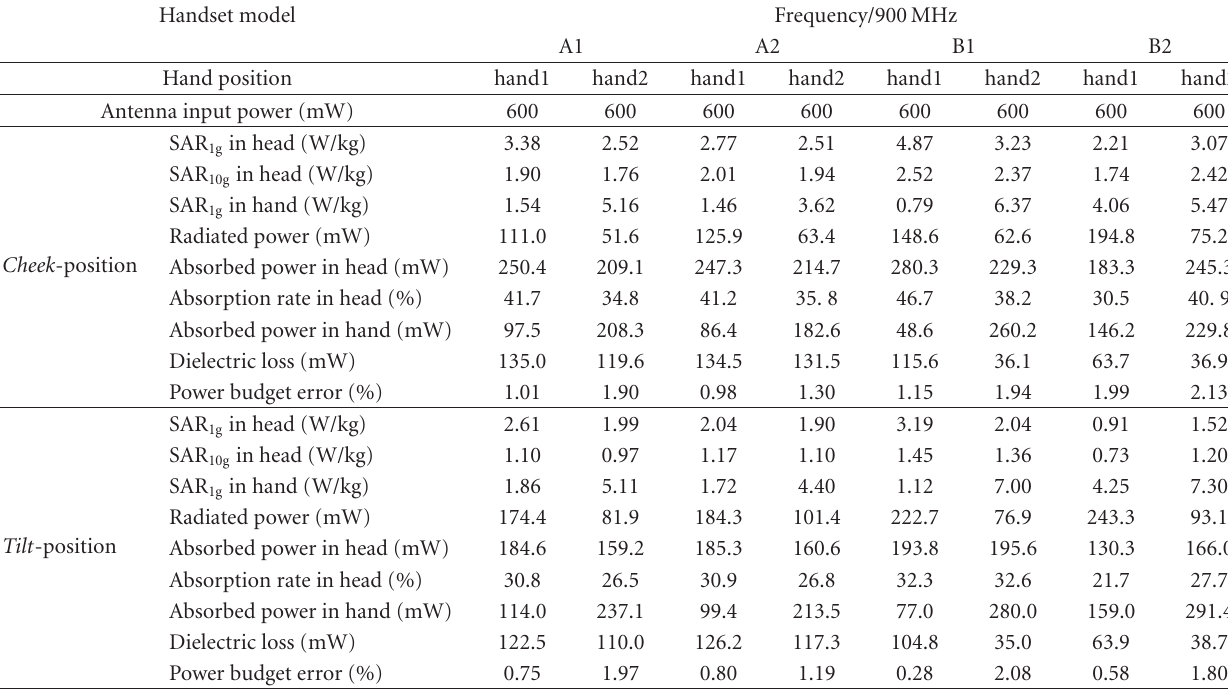
Table 8: Pooled statistics of peak 1 and 10 g SAR in tissues, radiated power, absorbed power in tissues, dielectric loss, and power budget error for the handset models in hand closed to HR-EFH at di ff erent positions operating at 900